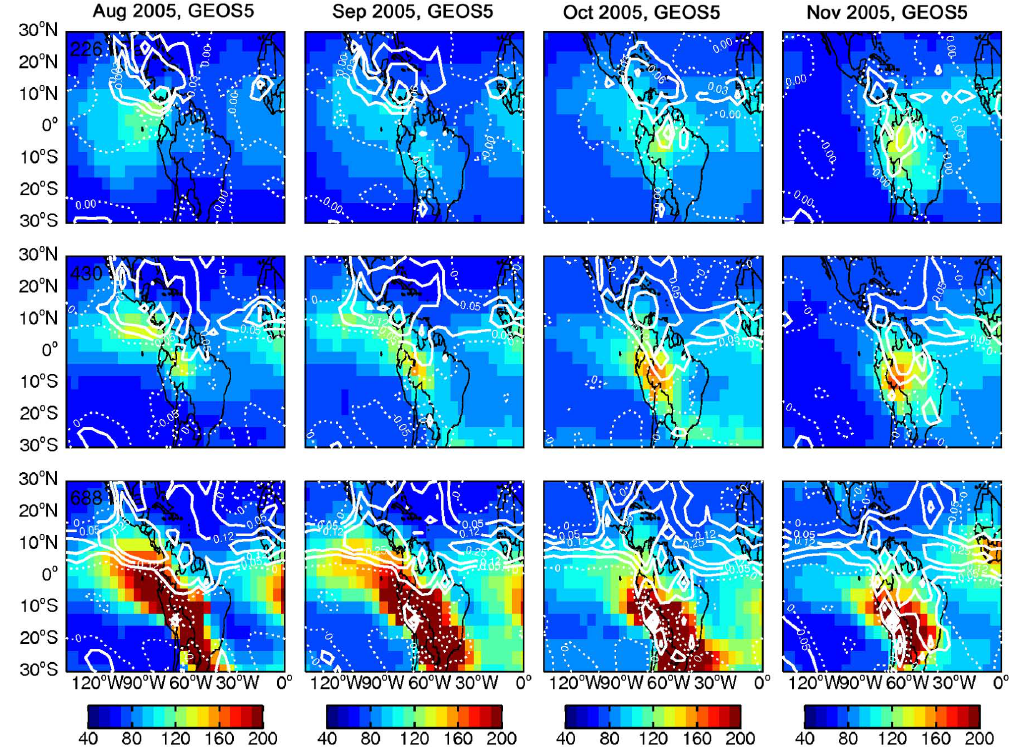
Fig. 10. Spatial patterns of the vertical air mass flux (contours in Pas − 1 ) superimposed on the CO mixing ratio (colors, in ppb) from August to December 2005 in the model driven by GEOS-5. See Fig. 9 for further details.